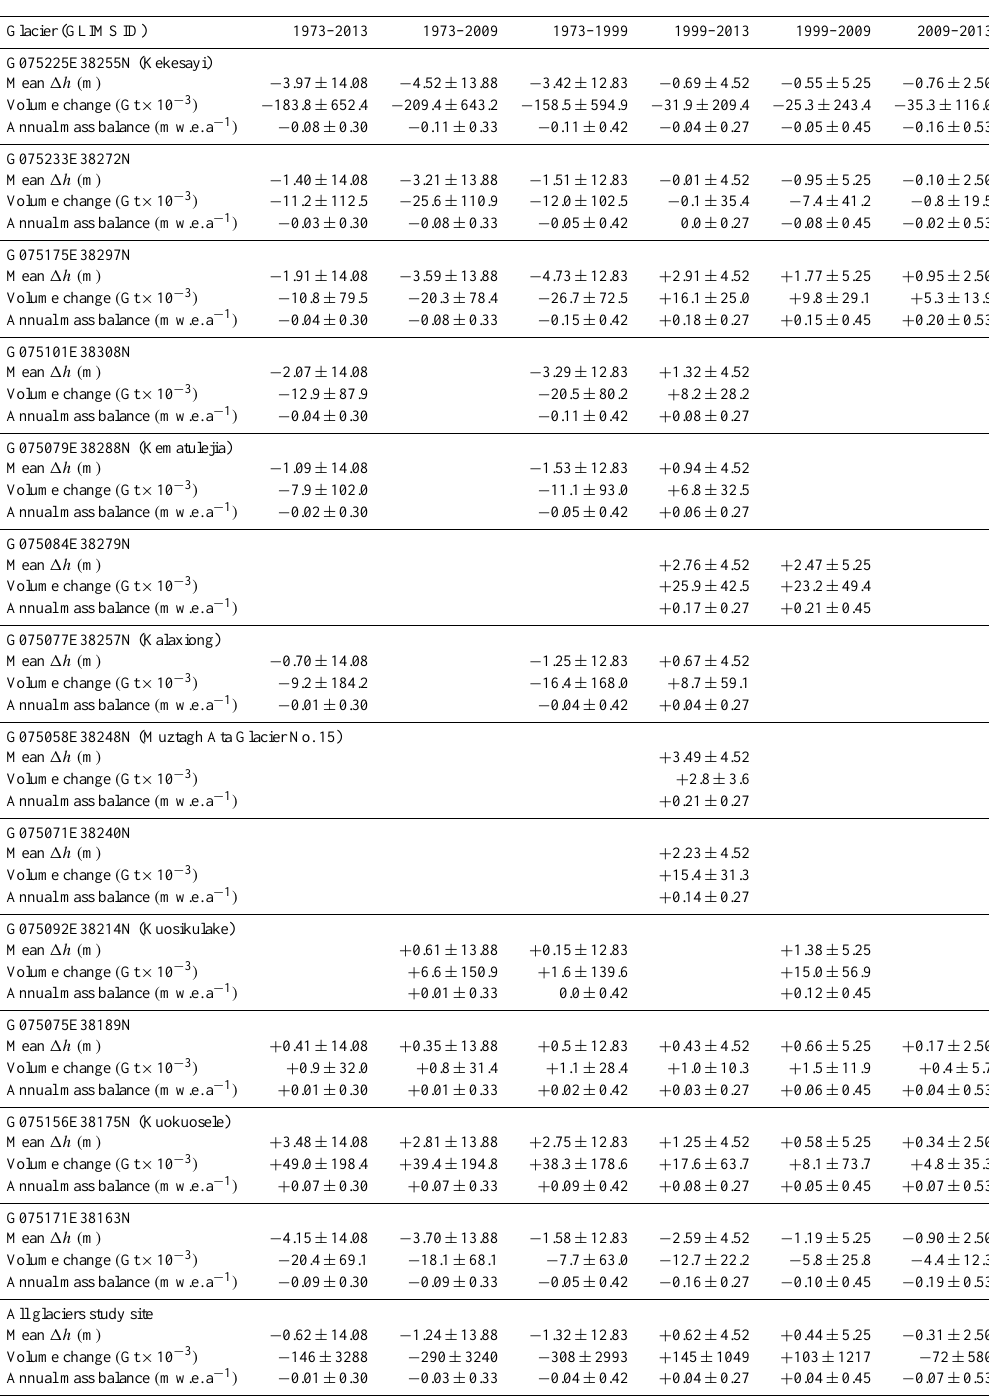
Table A1. Glacier mean elevation ( (cid:49)h ) and total ice volume changes, as well as geodetic glacier mass-balance rates measured from DEM differencing of KH-9 Hexagon (1973), SRTM-3 (1999), ALOS-PRISM (2009), and Pléiades